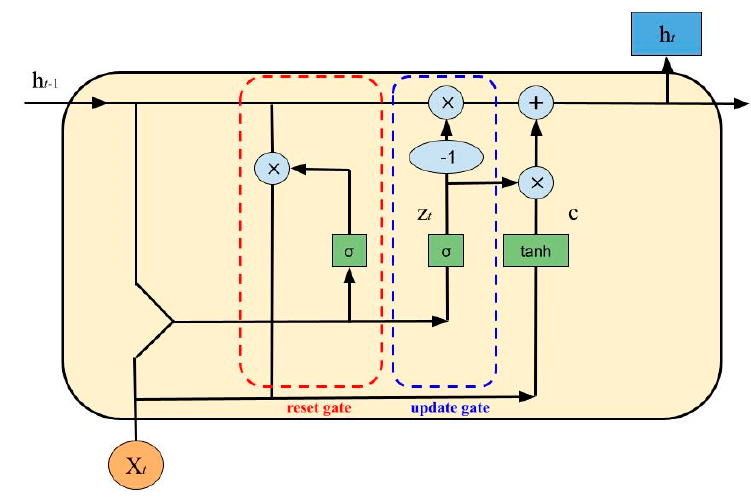
Figure 3. A GRU cell, where σ is the sigmoid function.